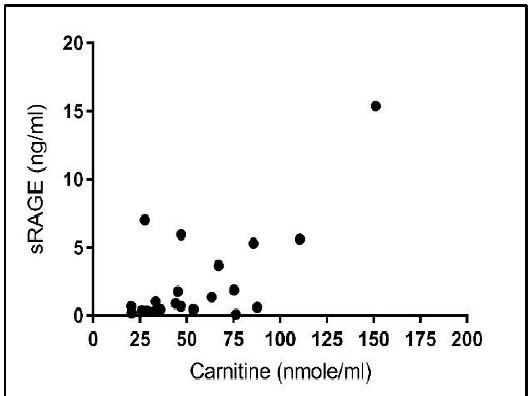
Figure 3. The correlation between patient serum carnitine and sRAGE levels (r=0.45, P-